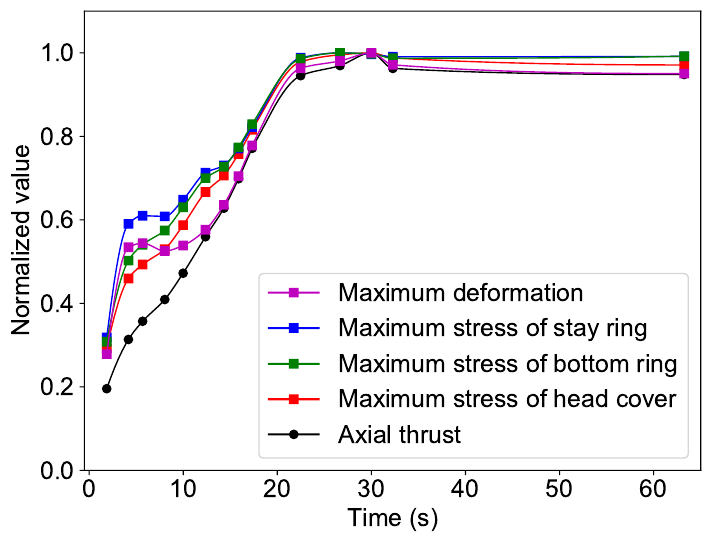
Figure 20. Comparison of maximum deformation, maximum stresses, and axial thrust during turbine